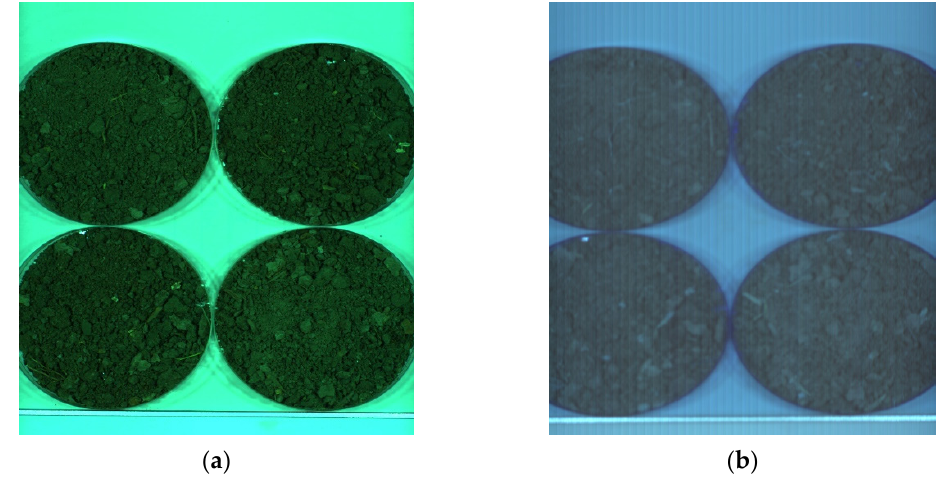
Figure 2. Images acquired by the GaiaSorter hyperspectral sorter system: ( a ) picture collected by Camera 1 (380–1100 nm); ( b ) picture collected by Camera 2 (900–2500 nm).